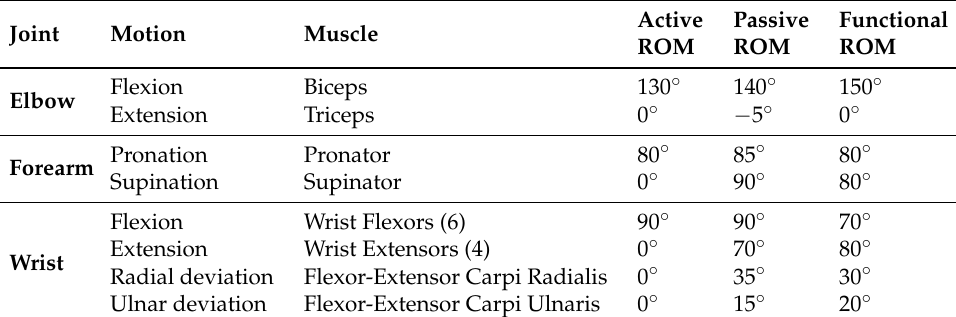
Table 3. Patient active-passive and functional ROM